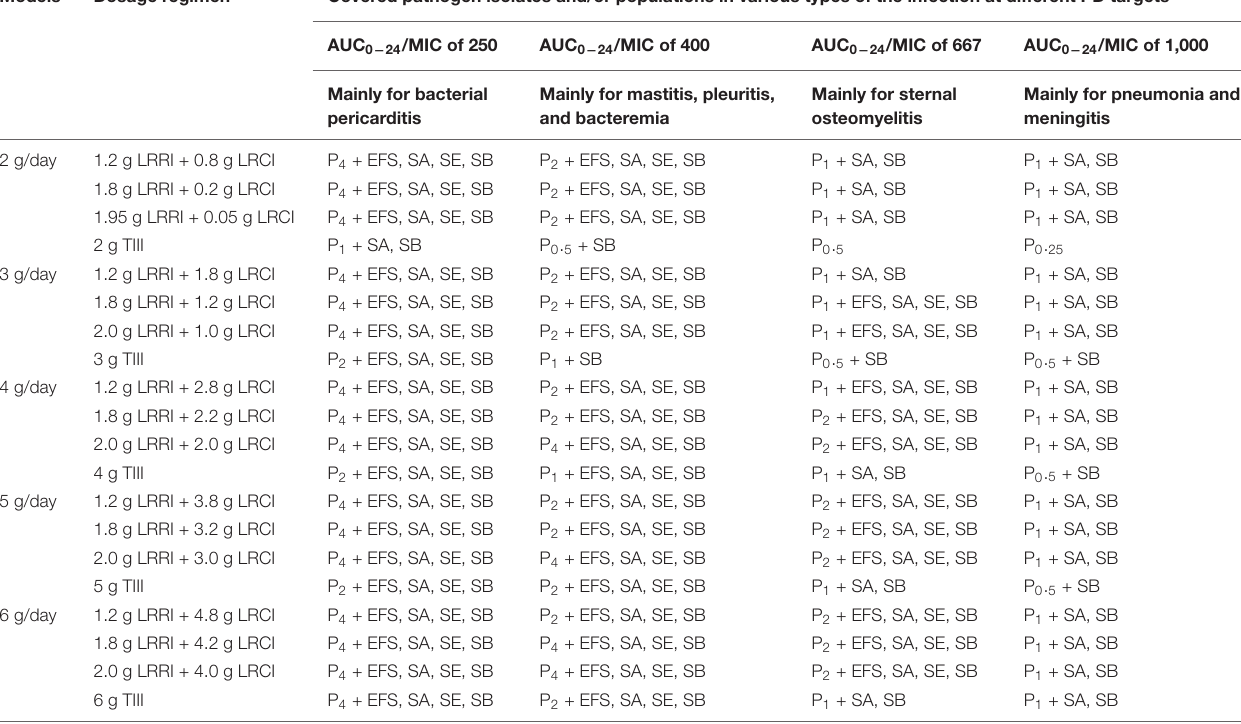
TABLE 4 | Coverage of the regimens for the isolates and/or for the targeted pathogen populations. Models Dosage